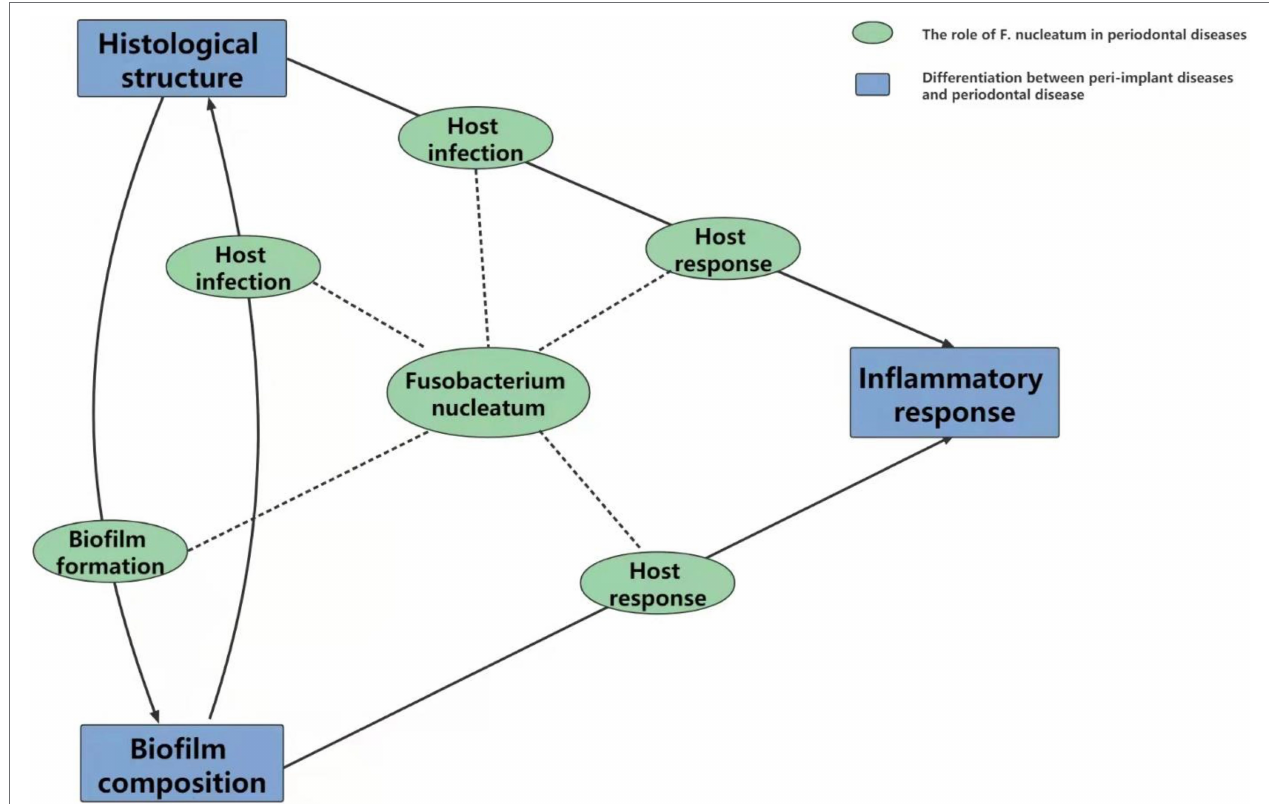
FIGURE 3 | The relationship between Fusobacterium nucleatum periodontal diseases and peri-implant diseases. Biofilms are universally accepted as mutual and critical factors in the initiation of periodontal and peri-implant diseases. The varied substrate for bacterial colonization and probably elevated function of Fusobacterium nucleatum in biofilm formation may be responsible for the reported discrepancies in its composition. With the succession of dental plaque, on the one hand, Fusobacterium nucleatum adheres to and/or invades host cells to induce mixed infection; on the other hand, invaded Fusobacterium nucleatum activates the human immune system to secrete inflammatory factors and accumulate inflammatory cells. These two effects cooperate with each other to elicit the ultimate inflammatory response. Detected differences between periodontal diseases and peri-implant diseases in histological structure and inflammatory response